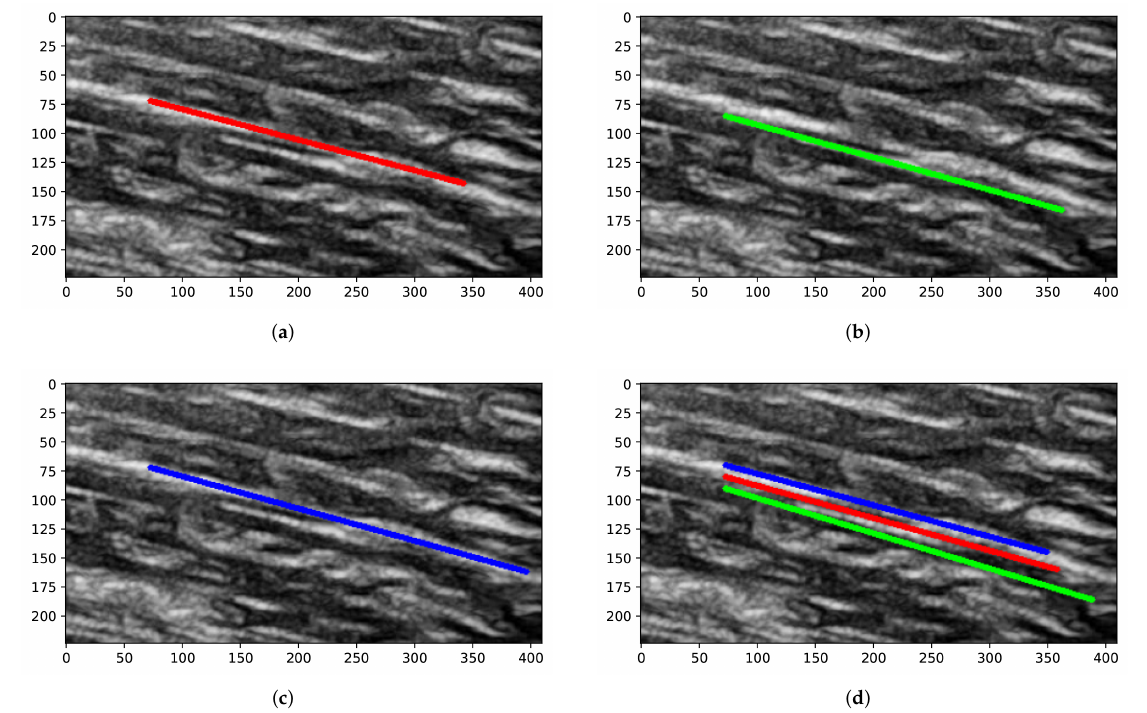
Figure 4. The measurement results of the direction of muscle fibers by different methods. ( a ) Manual annotation. ( b ) The result of the ResNet. ( c ) The result of the combination of the improved Kalman filter and ResNet. ( d ) Three results on one